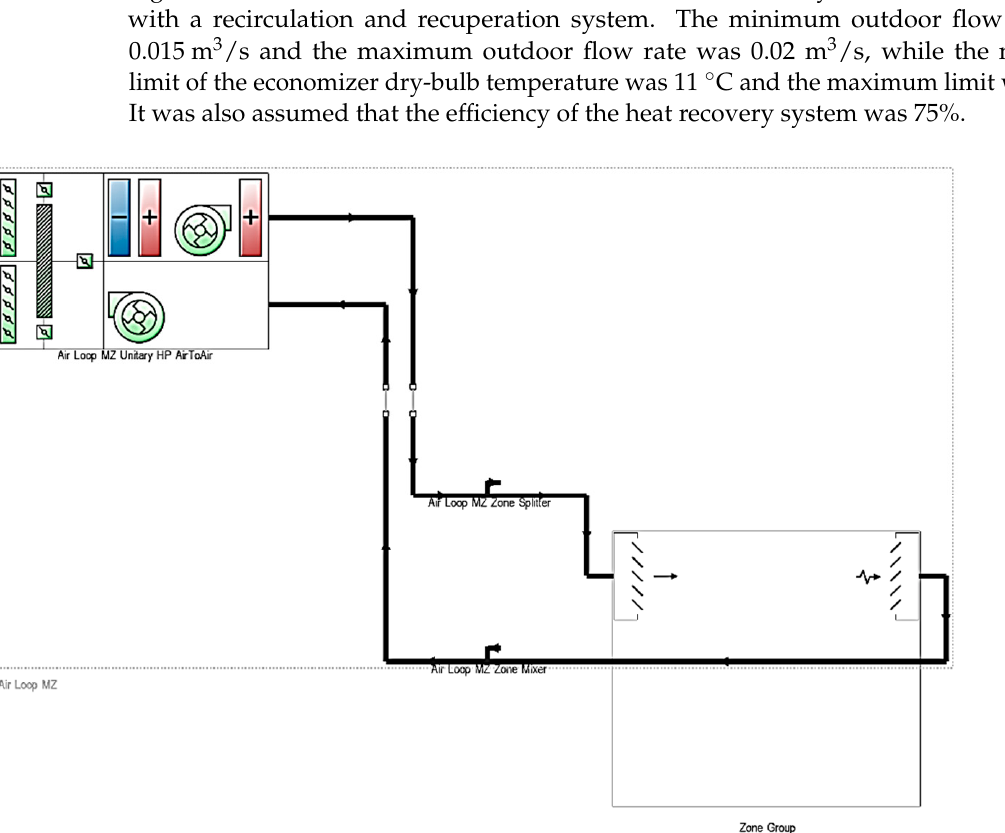
Figure 3. The ground source heat pump system used for heating applications cooperating with a mechanical ventilation system and a heat recovery component.